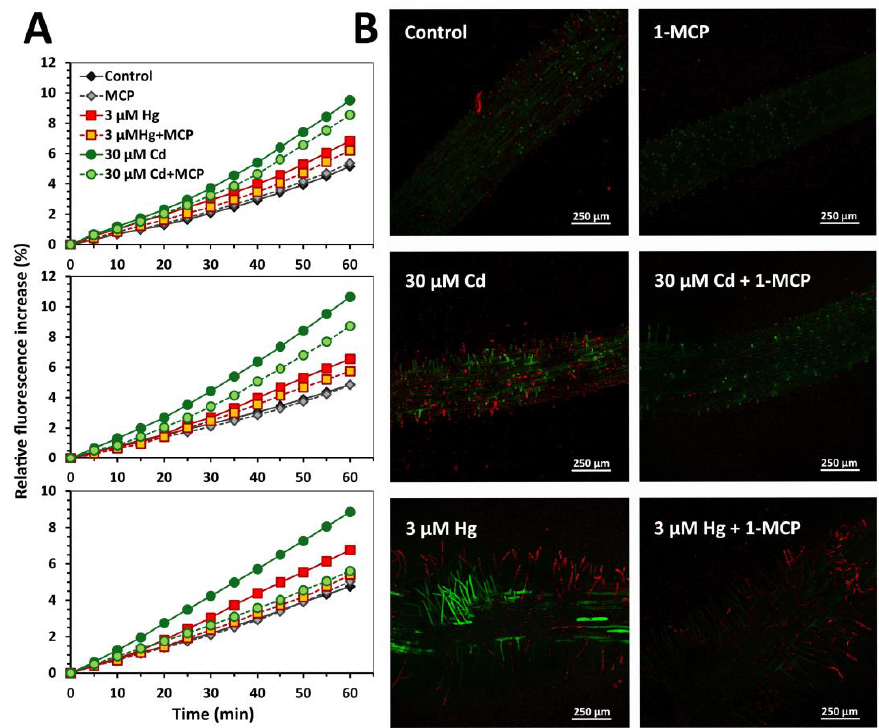
Figure 8. Apoplastic H 2 O 2 production and intracellular oxidative stress induced by Hg and Cd are alleviated when ethylene signalling is blocked by 10 µM 1-MCP in M. sativa root segments. ( A ) Extracellular H 2 O 2 production measured as Amplex Red fluorescence (%, relative to time 0) in alfalfa roots segments exposed to control, 3 µM Hg or 30 µM Cd in presence or absence of 10 µM 1-MCP, measured during 60 min. ( B ) Confocal fluorescence microscopy to detect oxidative stress (H 2 DCFDA, green pseudo-colour) in alfalfa seedlings treated as in ( A ) for 6 h. Seedlings were counterstained with propidium iodide (PI, red pseudo-colour) to highlight cell walls and dead cells. Representative images of at least three independent experiments are shown.